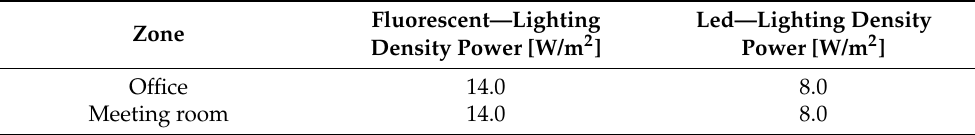
Table 11. Lighting density power for the current building and the replacement